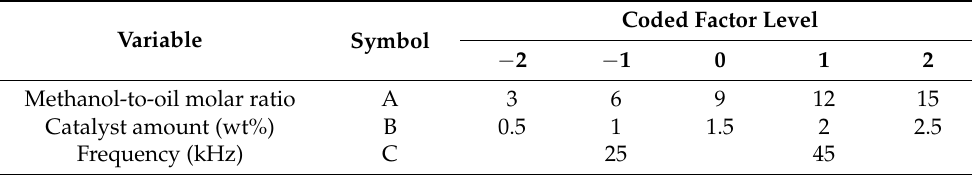
Table 2. Factors and their levels for CCD.